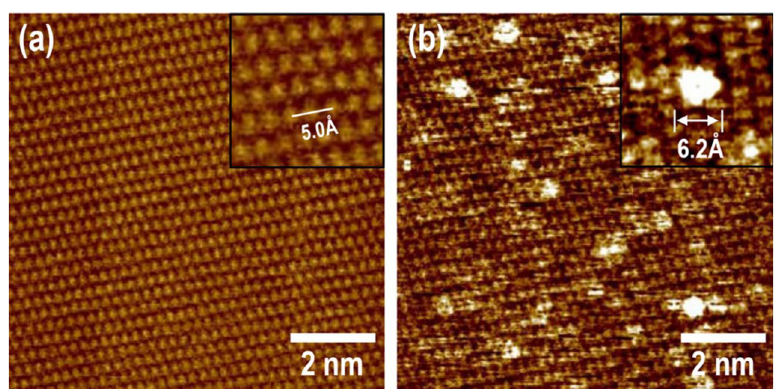
Figure 2. STM images of ( a ) pristine and ( b ) Cp * Ru + -graphites. Insets in ( a ) and ( b ) show enlarged images of hexagonal lattice structure of graphite and Cp * Ru + -fragment bound on graphite lattice structure, respectively. Cp * Ru + -graphite samples used in our STM experiments were prepared via reaction in 1.25 × 10 −15 M solution for 10